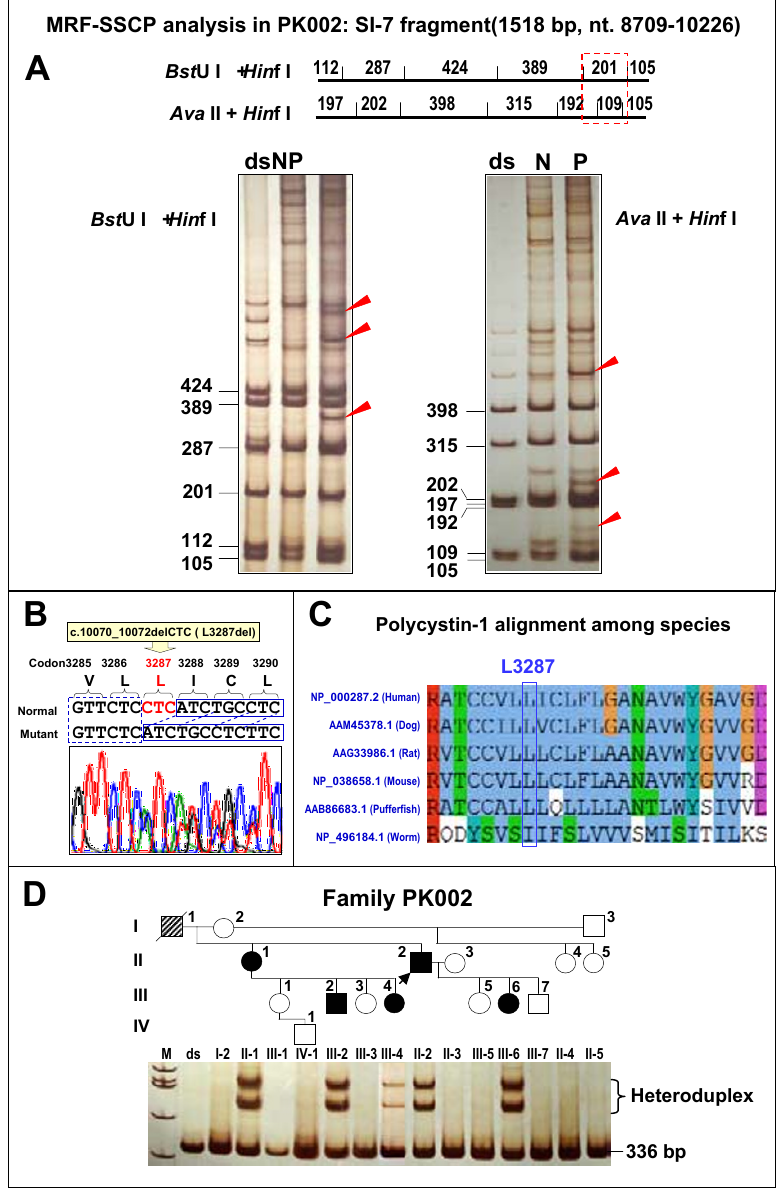
Figure 5 Novel in-frame deletion (L3287del) identified in family PK002. A. MRF-SSCP analysis of SI 7 fragment of the patient. The restriction map shows multiple fragment sizes obtained from digestions with two sets of restriction endonucle- ases (upper). The dotted square indicates the region with mobility shifts in the digested SI 7 fragment from the patient of family PK002. The SSCP patterns generated from digestions with two sets of enzymes (lower) and mobility shifts of single-stranded DNA (pointed) are shown. B. Direct sequencing analysis of PKD1 -cDNA from the patient. The sequencing profile shows a deletion of three nucleotides (CTC; c.10070_10072del), resulting in an in-frame mutation. The CTC deletion causes missing of leucine at position 3287 in polycystin-1 (L3287del). C. Multiple sequence alignment of polycystin-1 from human, dog, rat, mouse, pufferfish and worm by using ClustalW program [33]. Amino acid residues around L3287 are shown. L3287 is highly conserved among distant species in which only in C. elegans that the residue is replaced by isoleu- cine, which is in the same group of amino acid. D. Direct detection for L3287del in members of the family PK002 by SSCP analysis. The L3287del could be detected by the presence of heteroduplex DNAs on the SSCP analysis. In the family PK002, five members carried the mutation while nine did not. M is standard DNA markers and ds is double-stranded DNA of a normal